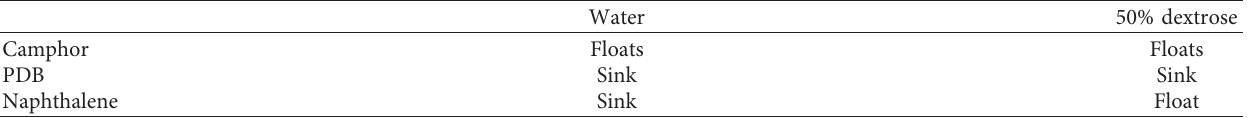
Table 2: Point-of-care test to differentiate between camphor, PDB, and naphthalene.